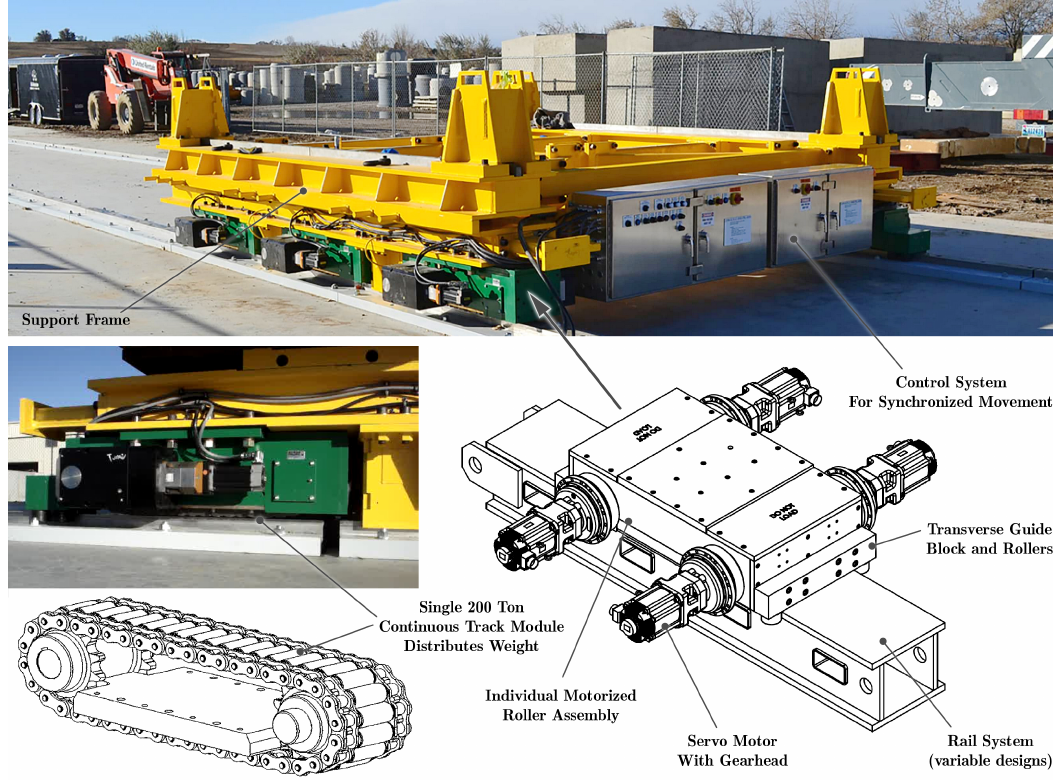
Figure 177. Industrial transport systems for extremely heavy loads and smooth movement are commercially available. This figure shows a continuous track system running on a band of high-strength chain rollers driven by synchronized servo motors. The shown setup is patented by Hilman Inc. and would be well suited for the DUNE ND Prism movement system permitting smooth forward and back